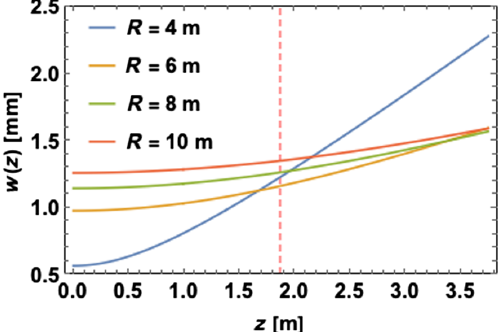
FIG. 5. The transverse size at 1 =e 2 of the intensity distribution of the laser beam inside the optical cavity. The position z ¼ 0 ð z ≃ 3 . 75 m Þ corresponds to that of the plane (spherical) mirror. The geometrical center of the FPC is represented by the vertical